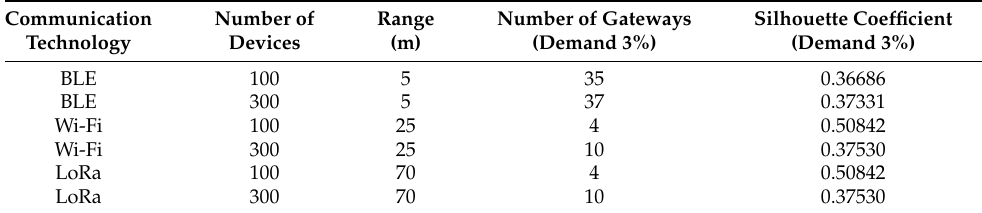
Table 14. The silhouette coefficients after applying the hybrid PSO model, considering the number of gateways that resulted from the application of the LP